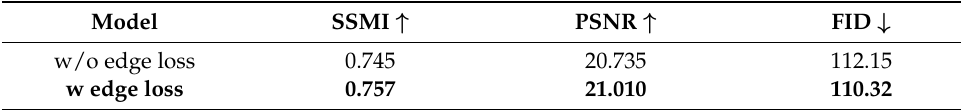
Table 2. Comparison of the influence of edge loss in